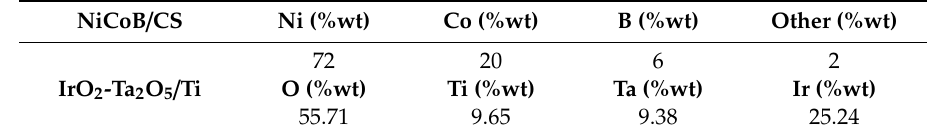
Table 1. Chemical composition of the NiCoB / CS and IrO 2 -Ta 2 O 5 / Ti